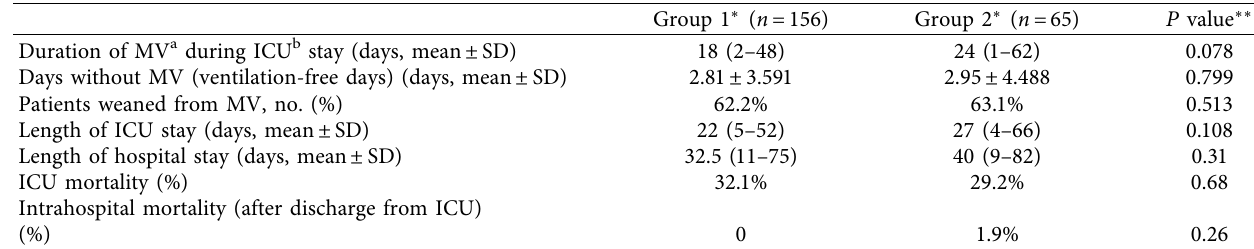
Table 3: Clinical outcome endpoints of both study groups (mean ± SD and